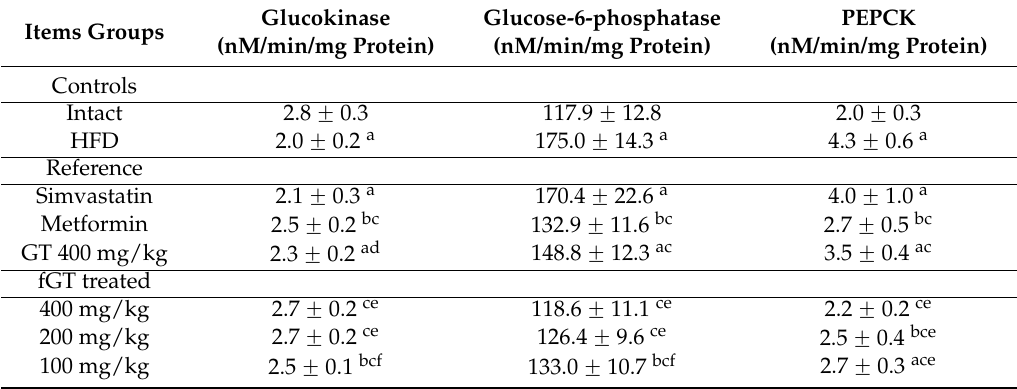
Table 10. Changes in the hepatic glucose-regulating enzyme activities in NFD or HFD supplied